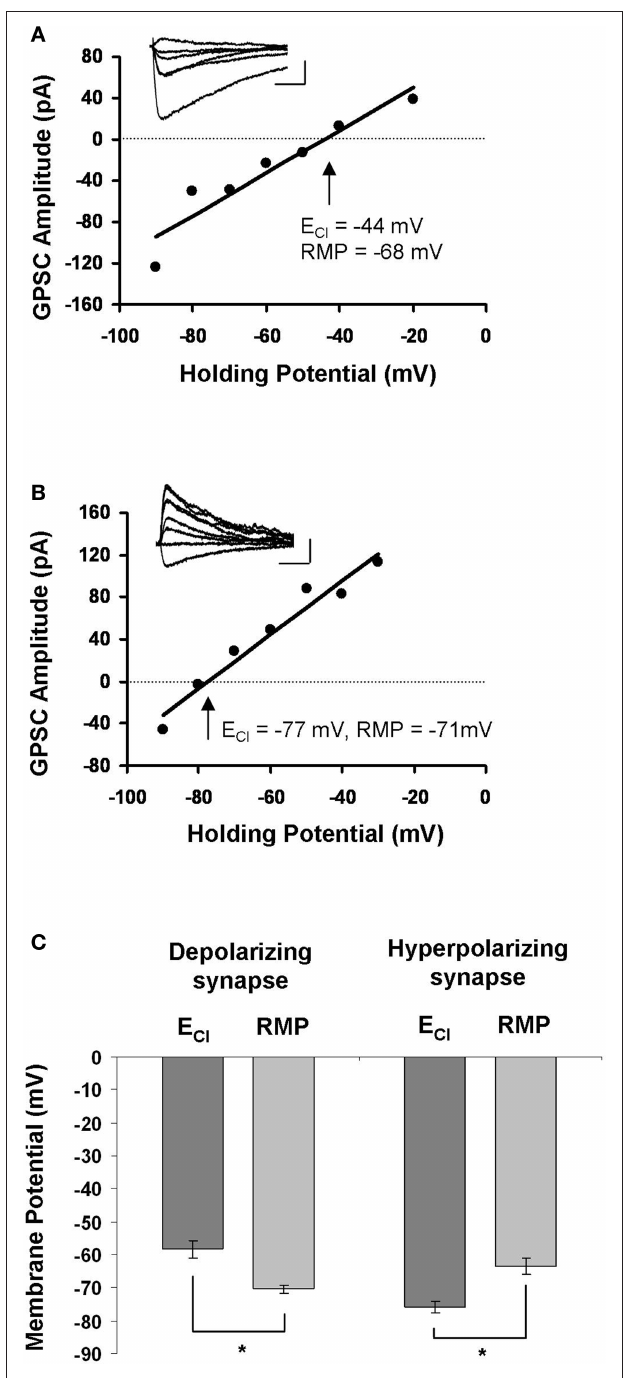
Figure 1 | Characterization of gABAergic synapses. (A) Example of an I–V curve from a depolarizing GABAergic synapse. The postsynaptic membrane potential was stepped in 10 mV increments while stimulating GABAergic synapses to generate the I–V curve. The holding potential at which the GPSC amplitude was 0 mV (dashed line) was taken as E . Inset: sample traces of Cl GPSCs recorded during the construction of the I–V curve. Legend: 20 ms, 45 mV. (B) Example of an I–V curve from a hyperpolarizing GABAergic synapse. Characterized as in (A) . Legend: 20 ms, 45 mV. (C) The average ± SEM for E and resting membrane potential (RMP) at depolarizing Cl and hyperpolarizing synapses. *indicates statistical